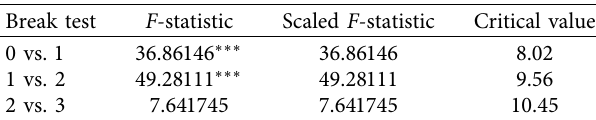
Figure 2: Chart of time series of original variables: (a) CO Table 3: Bai–Perron break